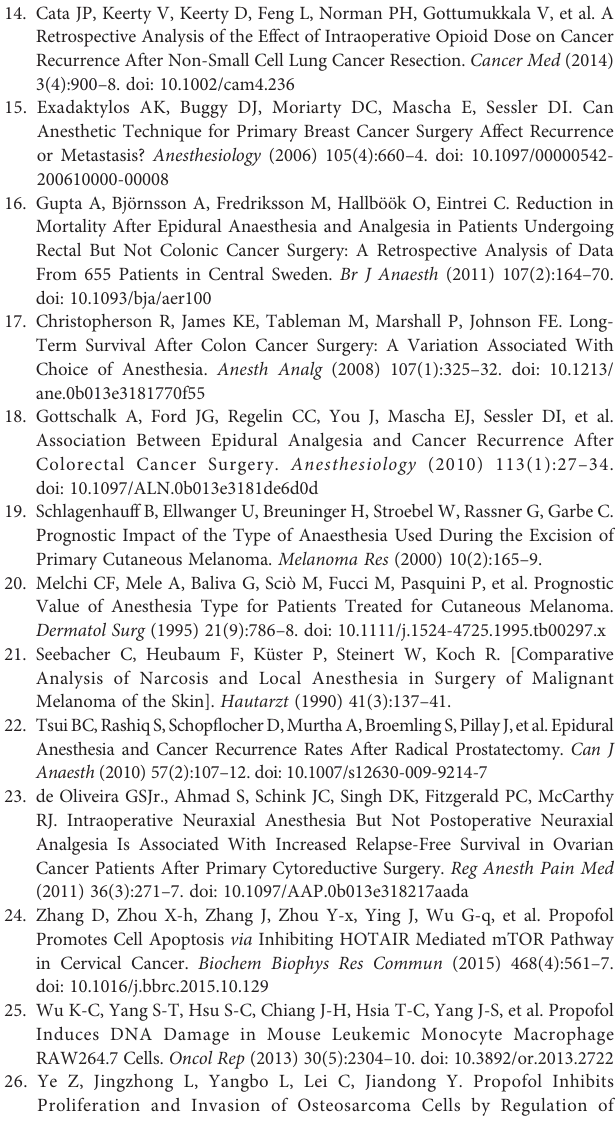
Supplementary Figure 1 | Output of publications and growth prediction of anesthesia andcancer research. Thenumberof publicationsfrom 2001to2020are represented by large scatters; the dashed line represents the predicted curve, R 2 =